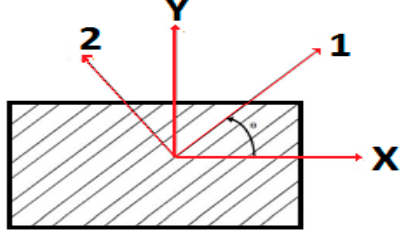
Figure 5. Local and global axes of an angle lamina.